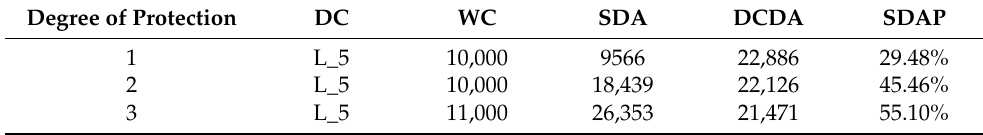
Table 7. Variations in LIRP decisions under different conservatism degrees (𝛽 = 100%) .